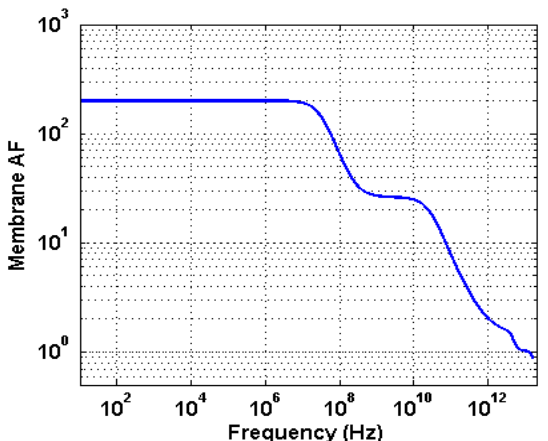
Fig.4: Membrane amplification factor G. The first drop occurs when displacement currents become dominant. The second drop occurs due to water relaxation around 20